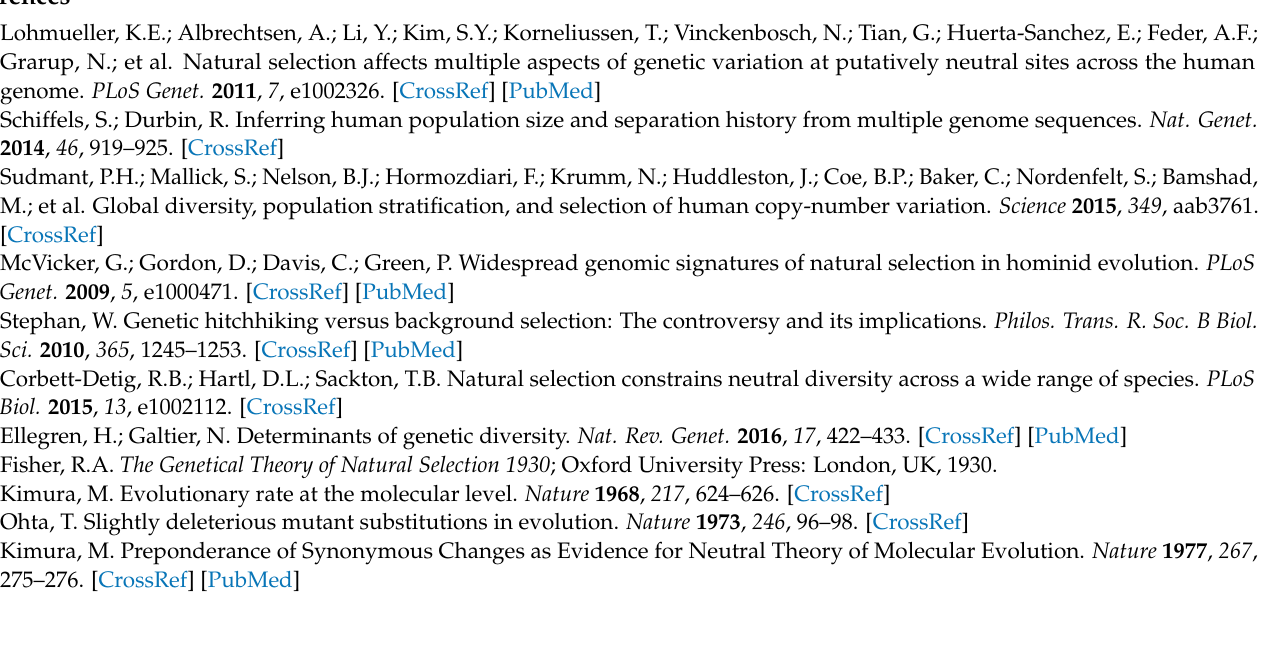
false discovery rate of